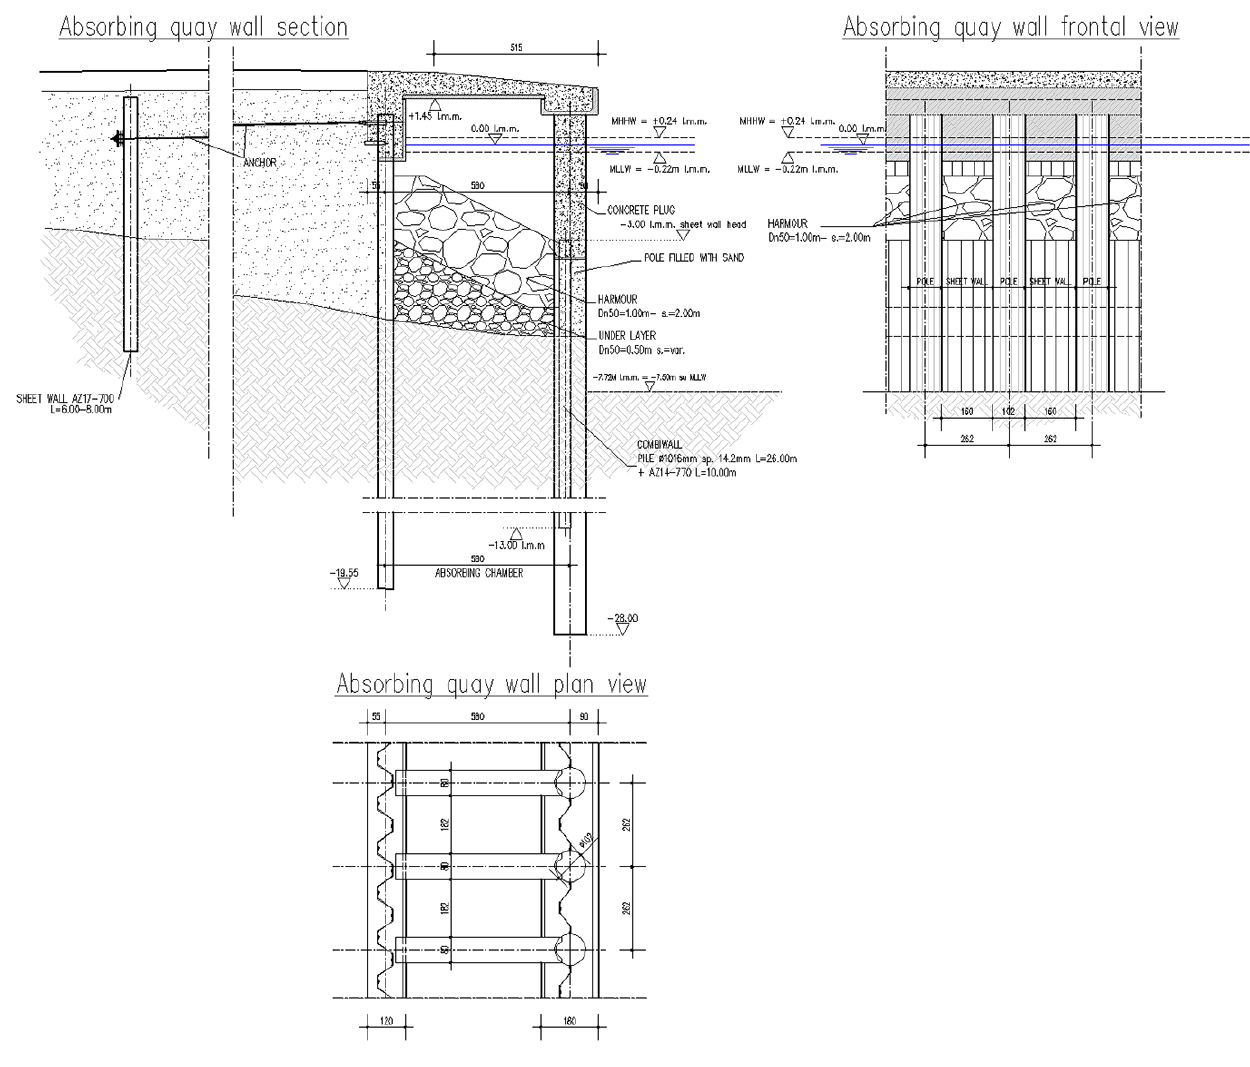
Figure 10. Absorbing quay wall section, plan and frontal views.